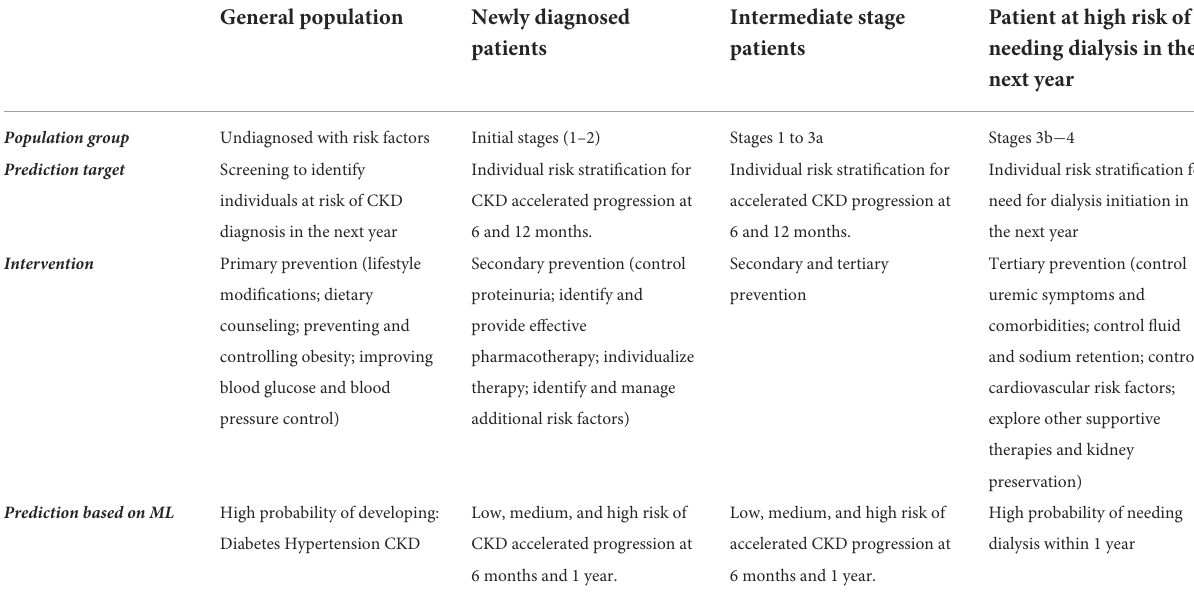
TABLE 1 Rationale of the machine learning-based risk stratification system and target